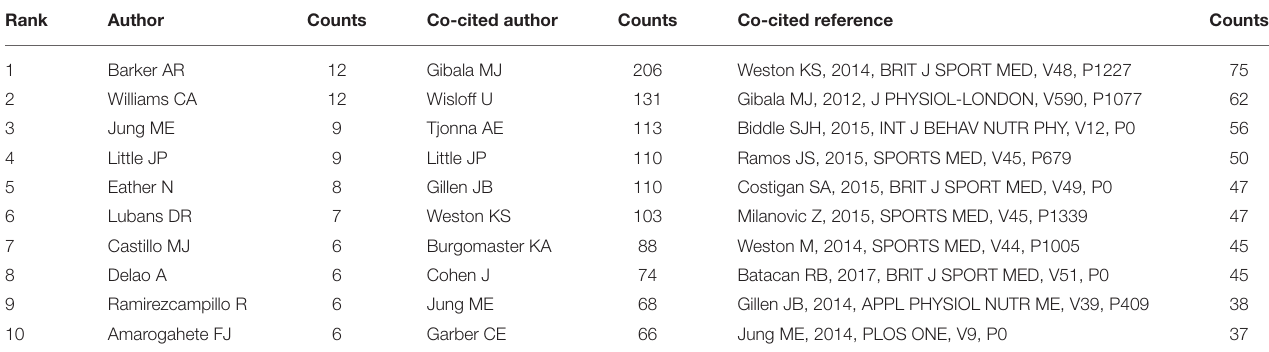
TABLE 3 | Ranking of top 10 authors, co-cited authors, and co-cited references in the HIIT-HP domain.